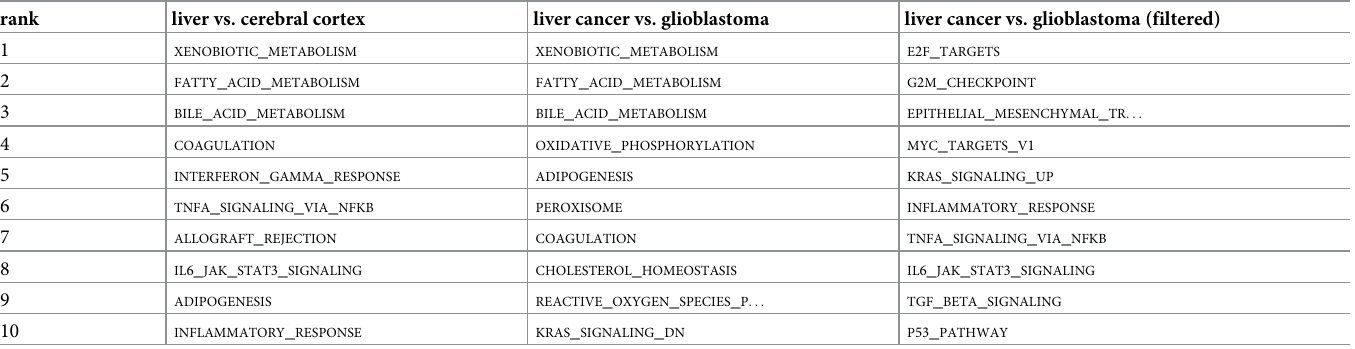
Table 5. Impact of normal tissue-specificity on comparative analysis of liver cancer and glioblastoma. The table lists the 10 MSigDB Hallmark pathways most signifi- cantly associated with relative gene expression between liver and cerebral cortex and between liver cancer and glioblastoma. Gene set testing of cancer relative expression was performed using all genes (middle column) and using genes filtered according to normal tissue differential expression (right column). Filtering specifically removed all genes whose log2 fold-change in expression between liver and cerebral cortex was � − 2 or � 2. Without filtering, differential gene expression between liver cancer and glio- blastoma is similar to differential expression between normal liver and cerebral